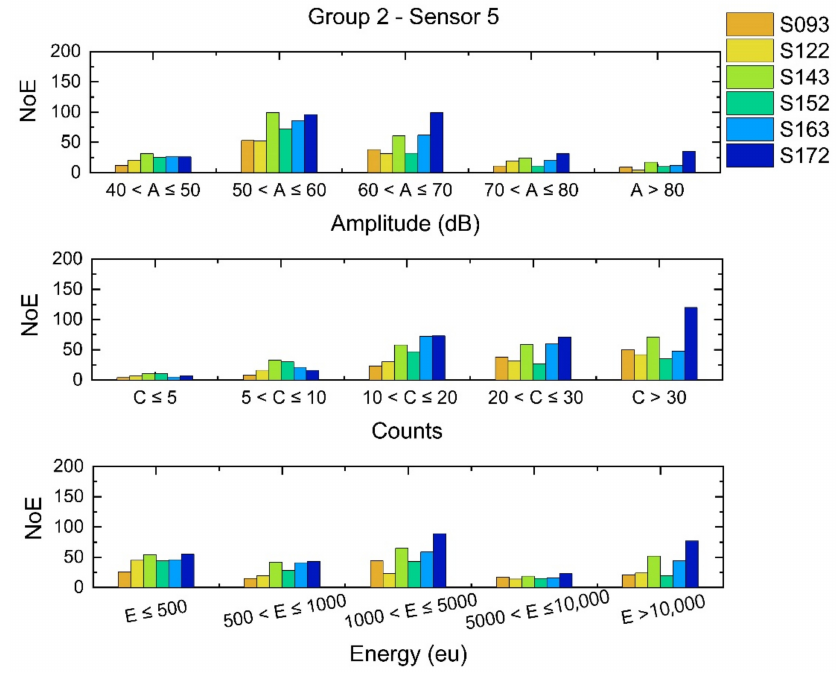
Figure 6. Number of events (NoE) registered during brittle fracture for Group 2 recorded by sensor 5. Each sample is identified by an ID number “Sxxy” corresponding to the number of slice (xx) and the count of the produced sample in the slice (y). ( Top ) amplitude; ( Middle ) counts; ( Bottom ) energy released by the fracture.